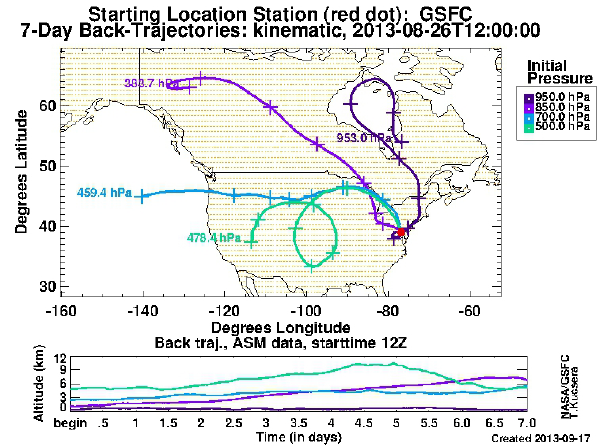
Figure 3. Back-trajectory analysis for 26 August 2013 at 12:00UTC. An air parcel at the 700hPa level (an altitude corre- sponding to ∼ 3km) over GSFC came from the northwestern US fire region approximately 5 days earlier (as indicated by the blue line in the plot).